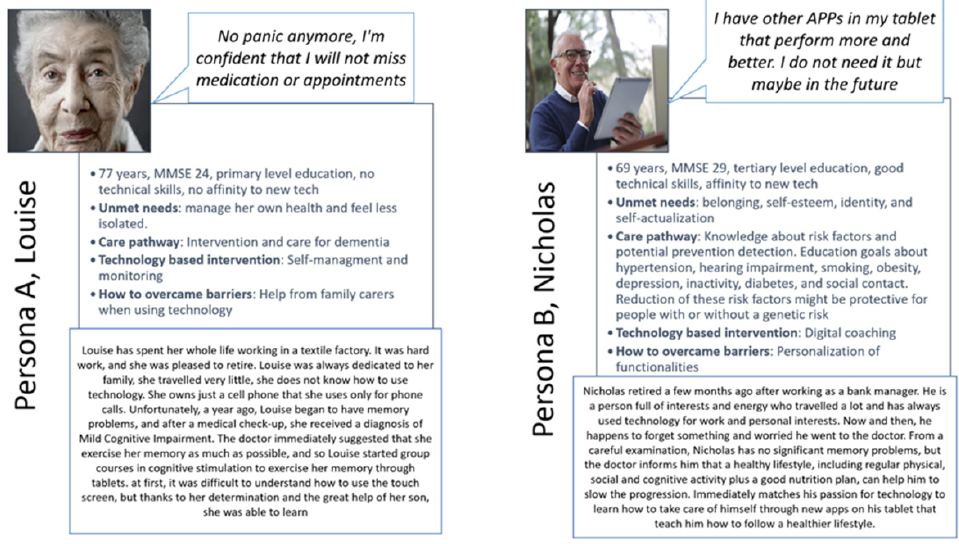
Figure 6. Persona A and B.